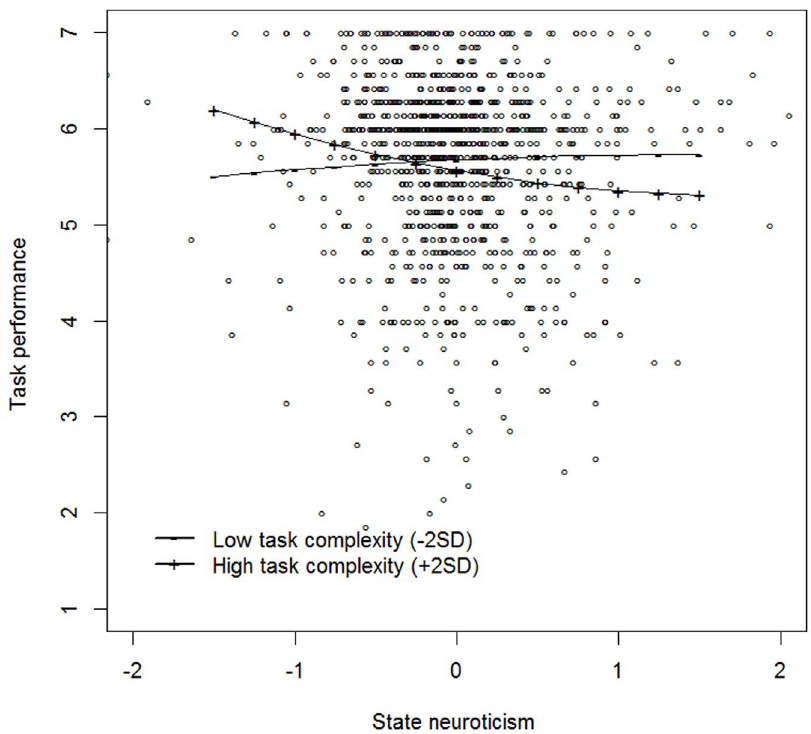
Figure 4. The moderating effect of low ( 2 2 SD ) and high ( + 2 SD ) levels of momentary task complexity on the state neuroticism – task performance relationship (Study 3). doi:10.1371/journal.pone.0106989.g004 PLOS ONE |